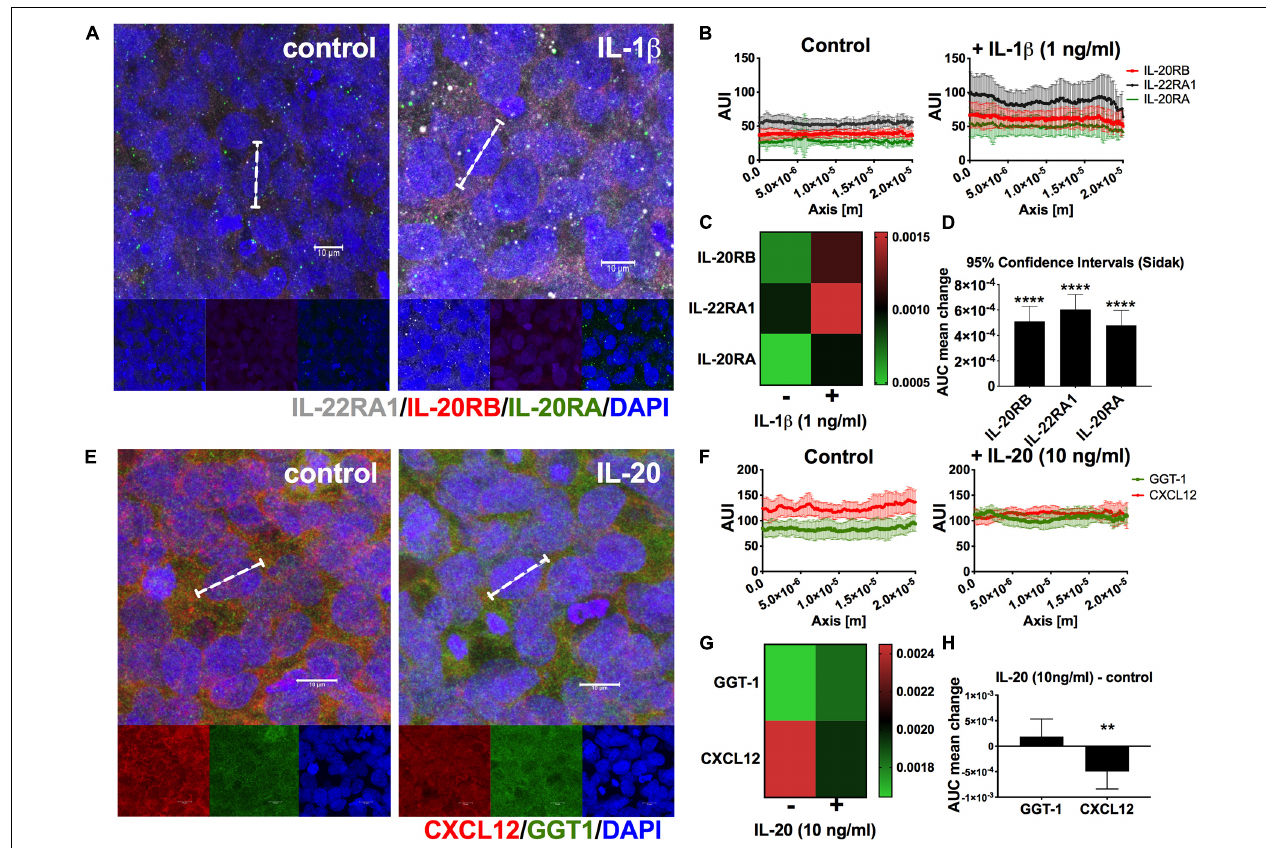
FIGURE 7 | Expression of IL-20 receptors and IL-20-mediated distortion in CXCL12 polarity in HCMEC/D3 cells. HCMEC/D3 seeded on eight-well slides were incubated for 24 h in the presence or absence of 1 ng/ml rhIL-1 β , n = 3. After 24 h, cells were immunolabeled for IL-22RA1 (white), IL-20RB (red), and IL-20RA (green) using DAPI (blue) for nuclear staining (A) . A total of 50 cells per group were analyzed to determine AUC as estimate for receptor subunits expression levels (dashed bracket shown a representative single cell, scale bar = 10 µ m) (A) . Graphic summary of AUI for control or rhIL-1 β -treated HCMEC/D3 cells, n = 50, used to calculate AUC (B) . Heatmap of change in AUC distribution of IL-20RA, IL-20RB, and IL-22RA1 between control and rhIL-1 β (C) . Two-way ANOVA followed by Sidak’s post hoc test showed that mean differences are statistically significant for all receptor subunits. Results are shown as mean ± SD, p < 0.0001. A similar approach was used to elucidate if IL-20 exerted changes in CXCL12 apicobasal polarity (D) . HCMEC/D3 were treated with 10 ng/ml rhIL-20, n = 3, for 24 h, and immunolabeled for basal marker CXCL12 (red), apical marker GGT1 (green), and DAPI (blue) for nuclear staining (E) . White dashed bracket shows representative single cell used for histogram analysis, scale bar = 10 µ m (E) . Graphic summary of AUI used to determine AUC, n = 25, for control or rhIL-20-treated HCMEC/D3 cells (F) . Heatmap of mean change in AUC distribution of GGT1 and CXCL12 between control and IL-20-treated cells (G) . Two-way ANOVA followed by Sidak’s post hoc test, showed a statistically significant change for CXCL12 and not for GGT1 (H) . Results are shown as mean ± SD, ** p < 0.01 and **** p <